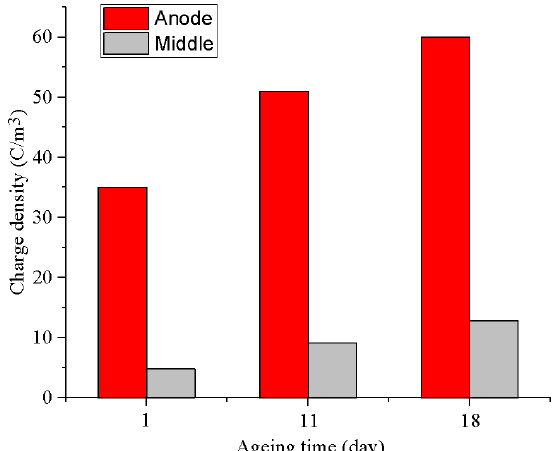
Figure 7. The charge density of the charges accumulated at the anode and in the middle position of the paper [19].